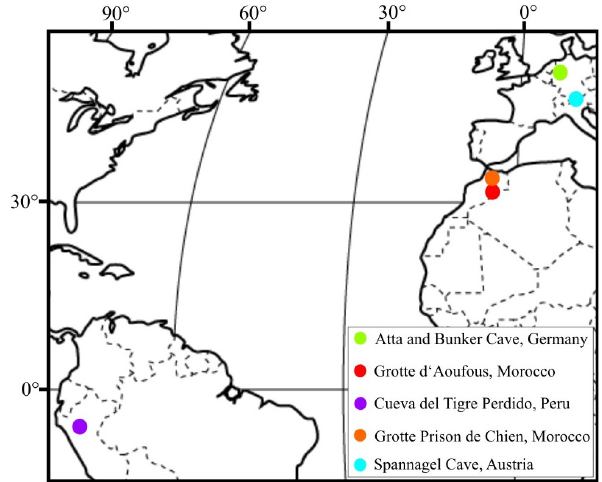
Fig. 1. Map with the locations of studied caves. Atta and Bunker Cave (Germany) are represented by a single green